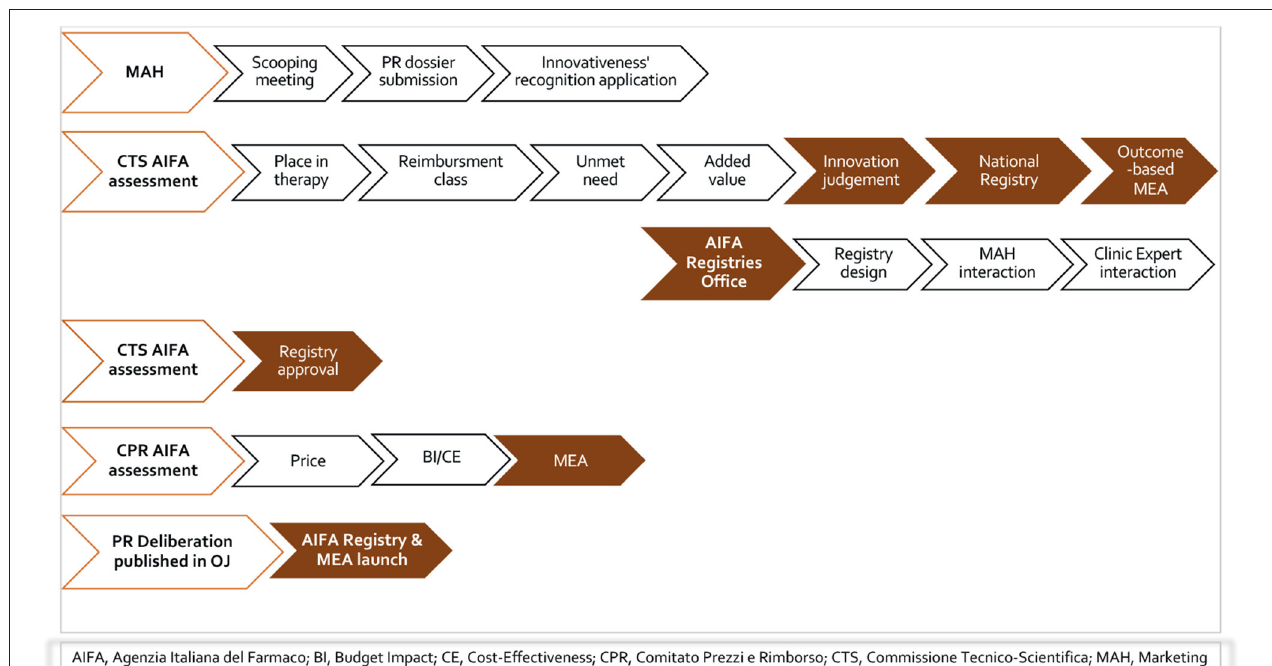
FIGURE 1 | The flow of AIFA decision on individual-level registry with or without